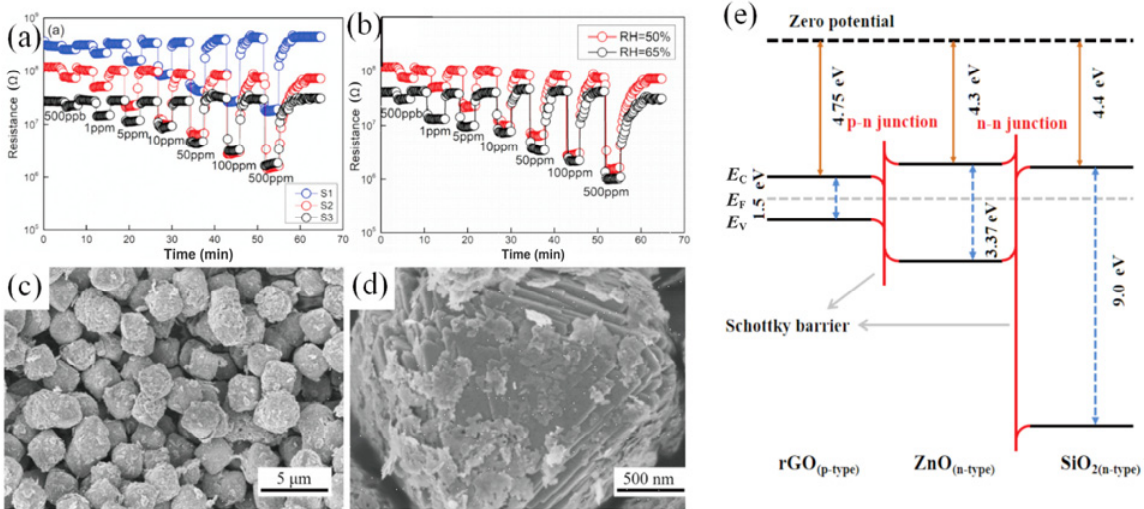
Fig. 4 (a) Response–recovery curves of three sensors to n-propanol gas with different concentrations. (b) Response–recovery curves of S2 ZnSnO 3 sensor upon exposure to n-propanol gas with different concentrations under RH = 50% and 65% at 200 ℃ . (c, d) Low-magnification and high-magnification SEM images of ZnSnO 3 nanospheres, respectively. (e) Energy band diagram of ZnO@SiO 2 /reduced graphene oxide (rGO) nanocomposite in target gas. Note: E C , E F , and E V represent the energy of the conduction band, the Fermi level, and the valence band, respectively. Reproduced with permission from Ref. [77] for (a–d), © Elsevier B.V. 2020; Ref. [41] for (e), © Elsevier B.V.